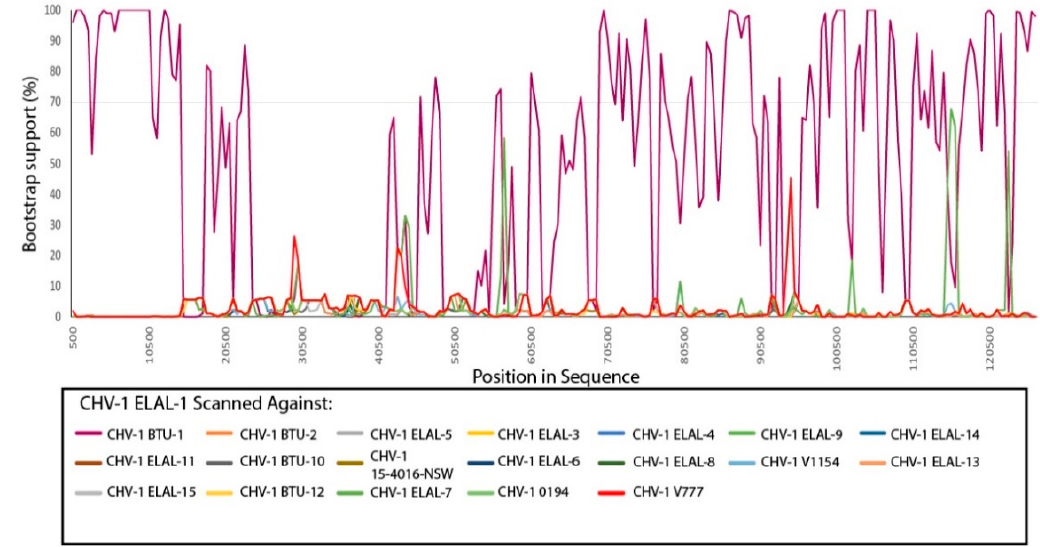
Figure 5. Manual bootscan results for recombination detection of CHV-1 ELAL-1 against all other analyzed isolates. A cutoff value of 70% bootstrap support is shown on the graph. Clear evidence of recombination was found between CHV-1 ELAL-1 and fellow Clade 2 isolate CHV-1 BTU-1, but not between CHV-1 ELAL-1 and any of the remaining isolates.